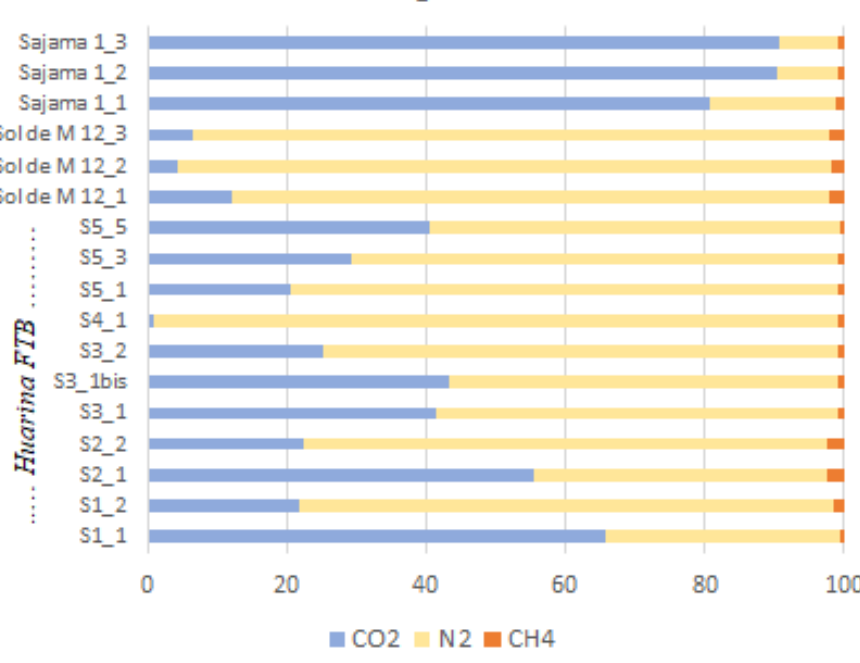
Figure 7. Main gas content after air correction. The Sol de Mañana area is characterized by its N 2 content (>85%), and the Sajama area is characterized by its CO 2 content (>80%). On the eastern border faults, it is a blend.